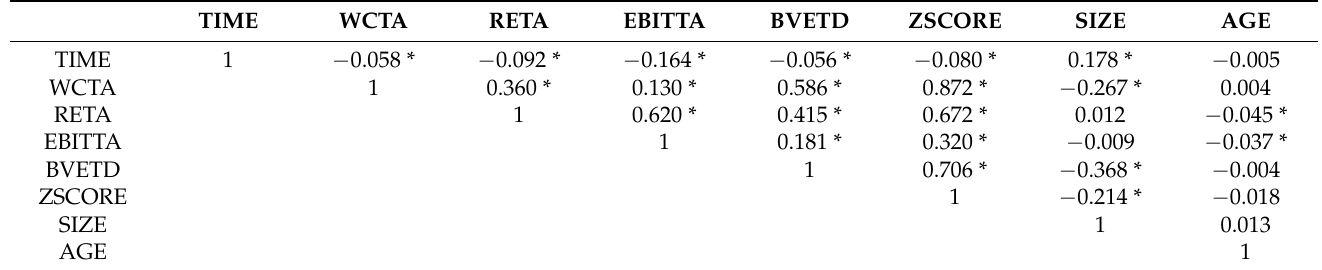
Table 4. Correlations between variables (Spearman correlation